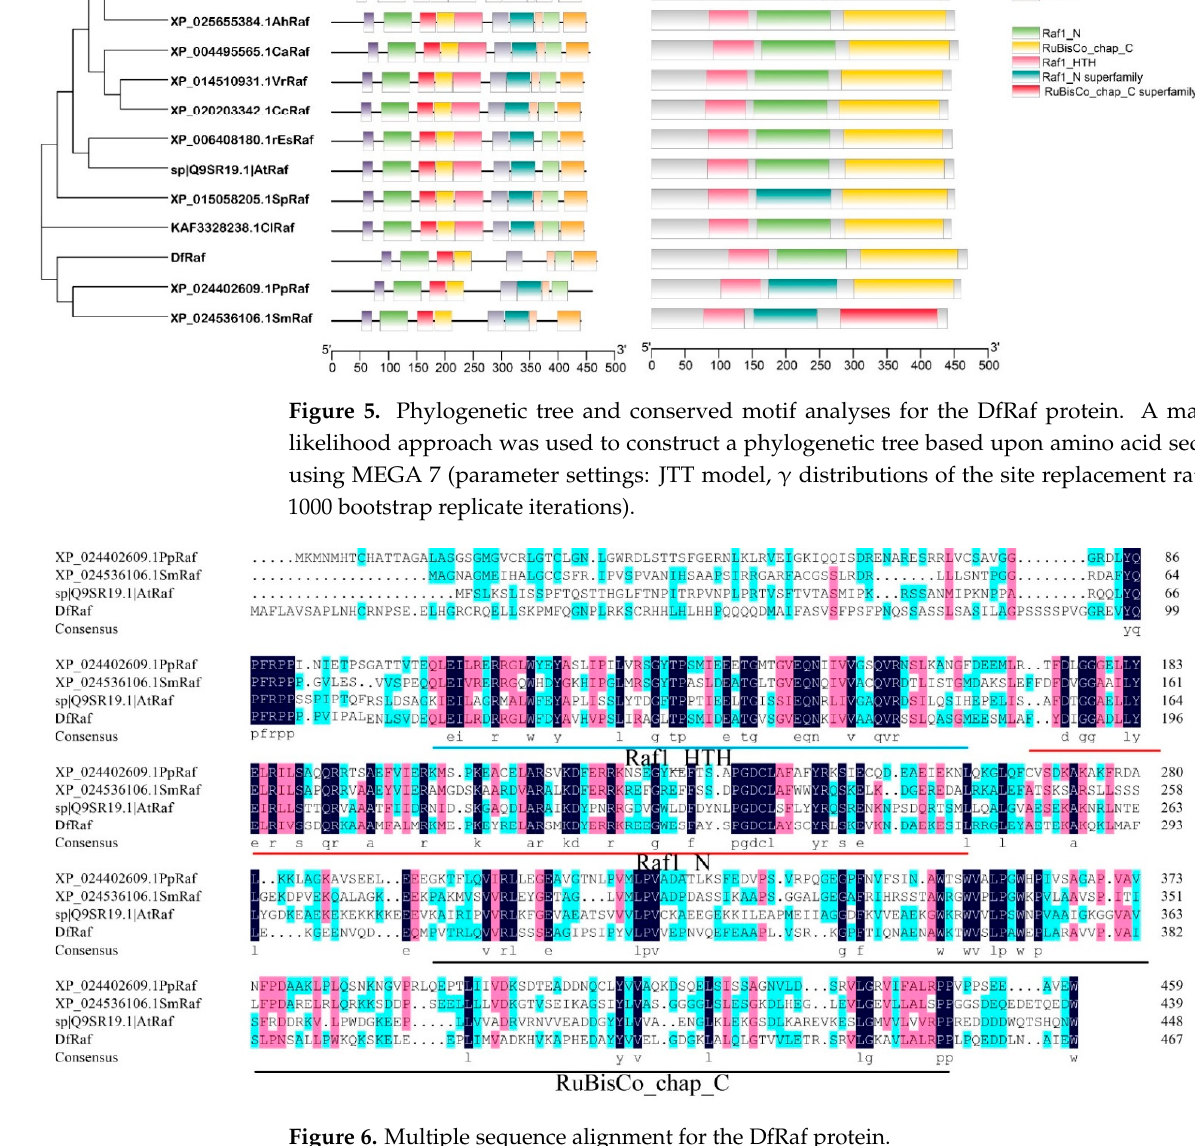
Figure 6. Multiple sequence alignment for the DfRaf protein.